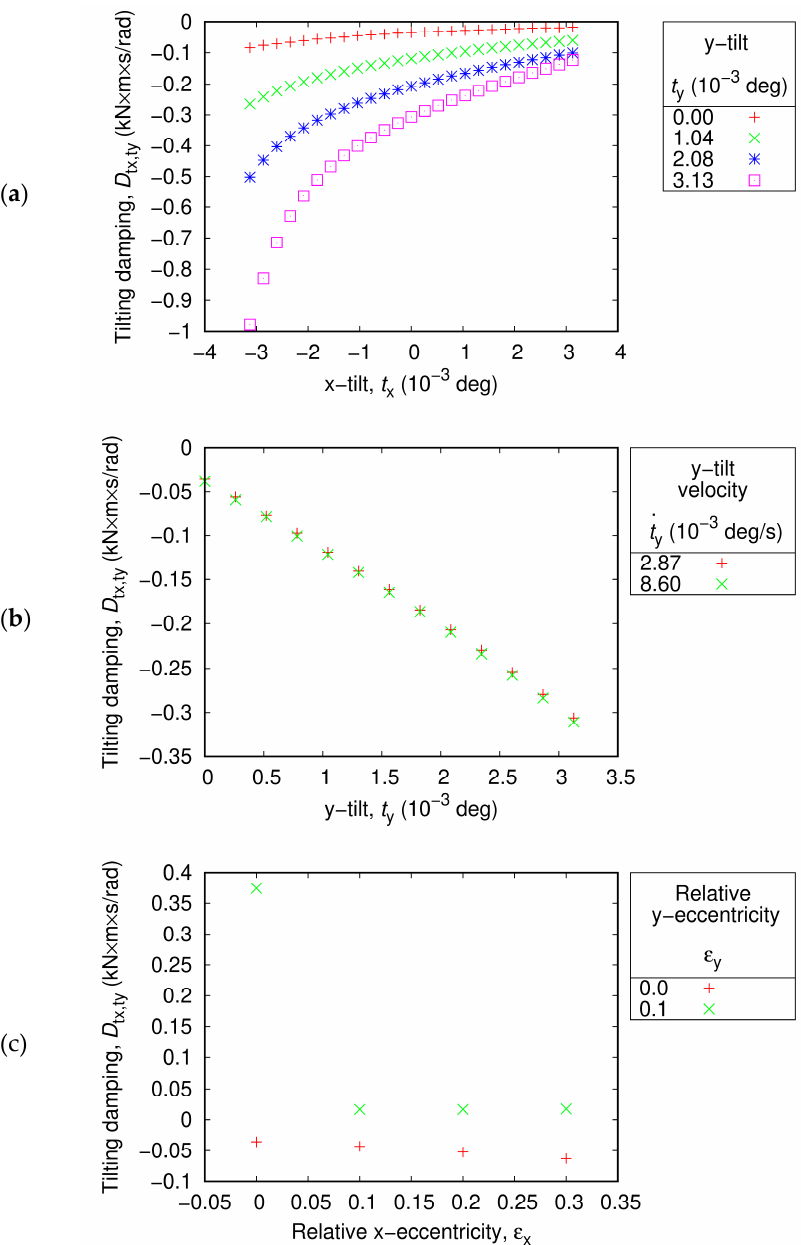
Figure 9. Parameter sensitivity of the cross-coupled damping coefficient D tx , ty : ( a ) Effects of x and y tilting angles; ( b ) Effects of the tilting angle and tilting velocity in the y-direction; ( c ) Effects of relative eccentricities. All unreferenced parameters have zero values.